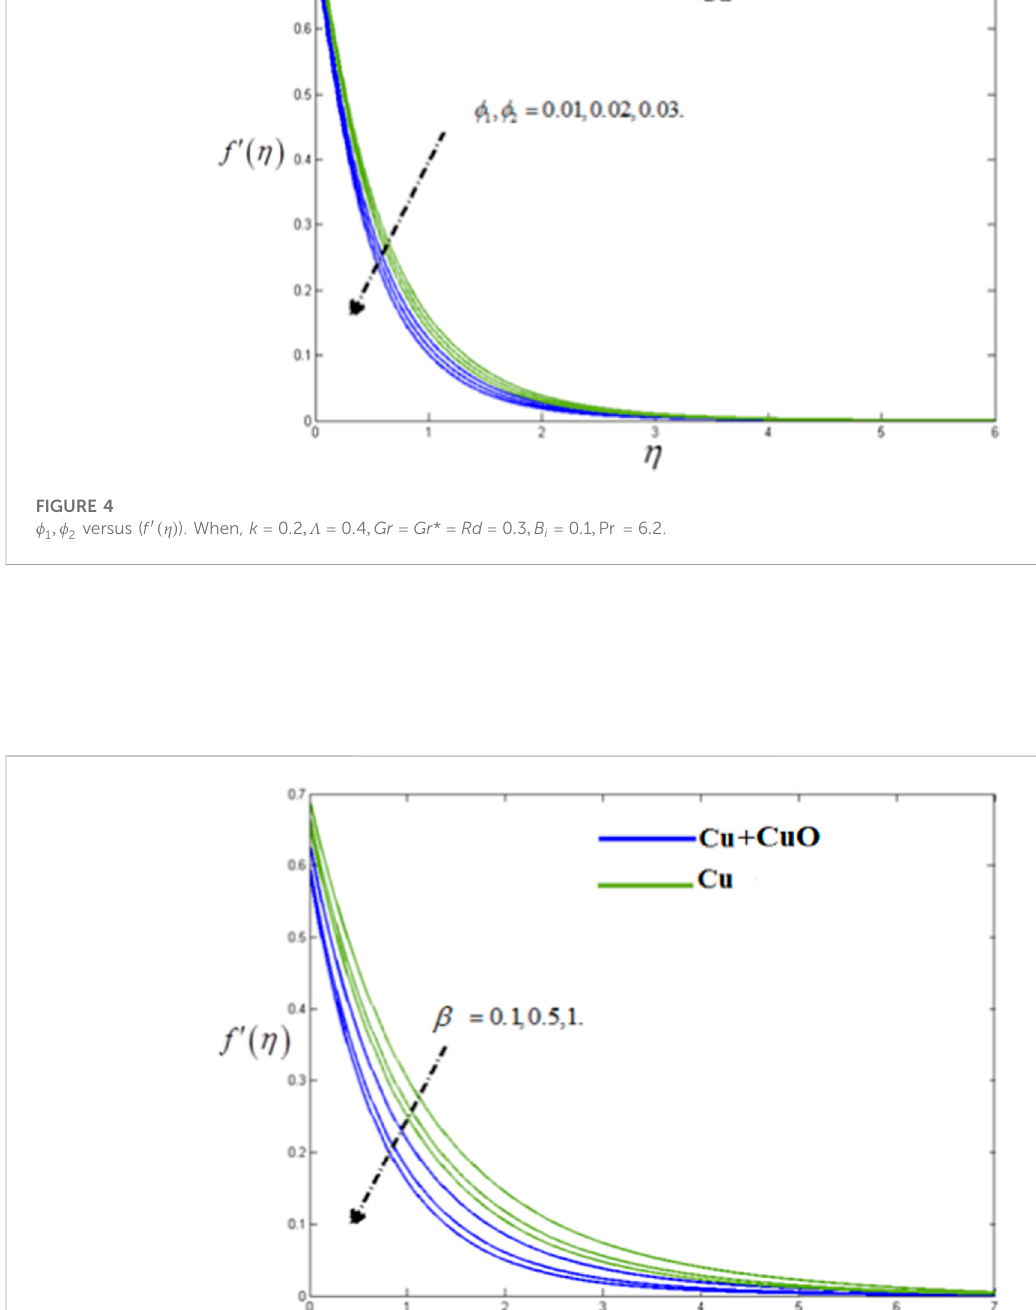
ϕ (cid:2) 0 . 02 , Rd (cid:2) 0 . 3 , B 1 , 2